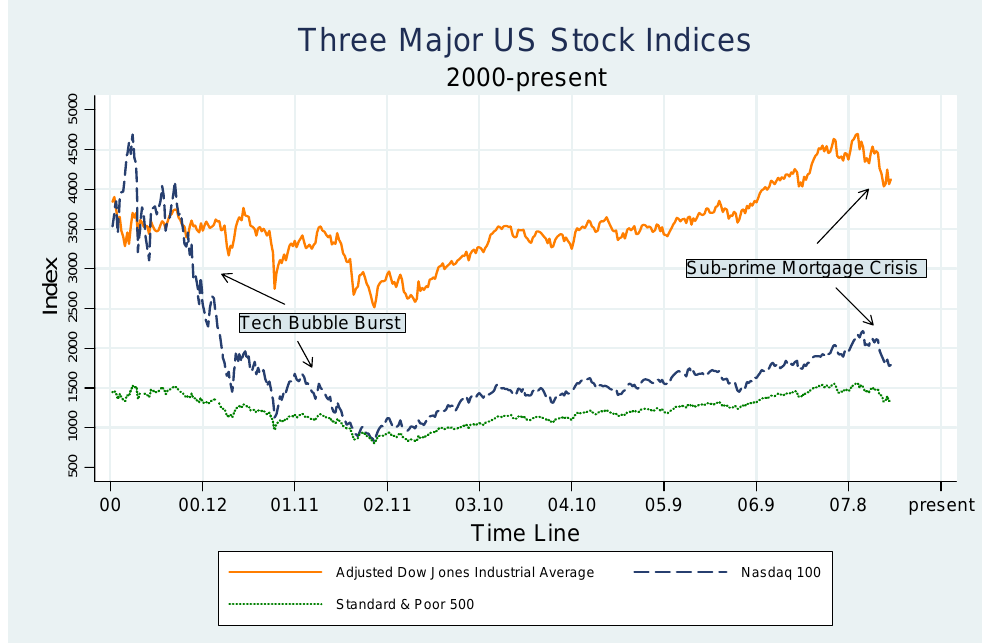
Figure 3: Three Major U.S. Stock Indices (2000 -